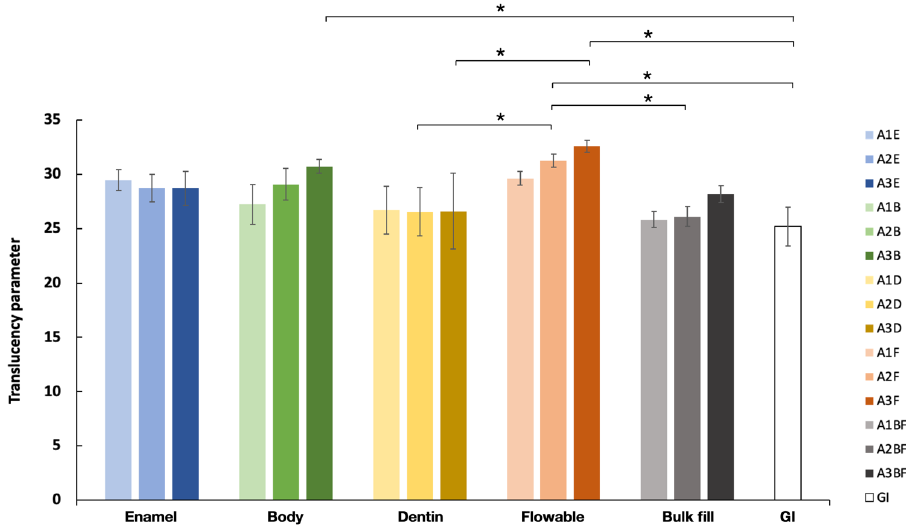
Figure 2. The translucency parameter of each shade of different types of restorative materials. *Indicates significant difference ( p <